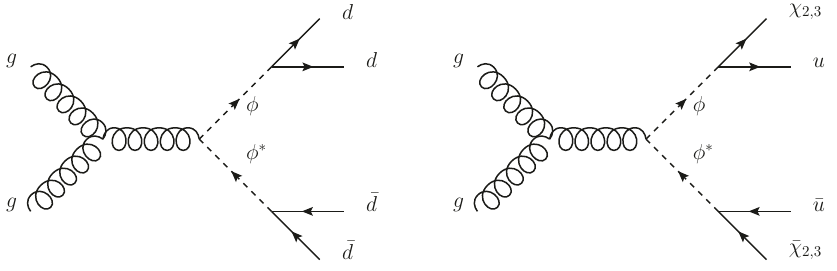
Figure 8 . Diagrams relevant for φ (left) searches and χ 2 , 3 production at the LHC.